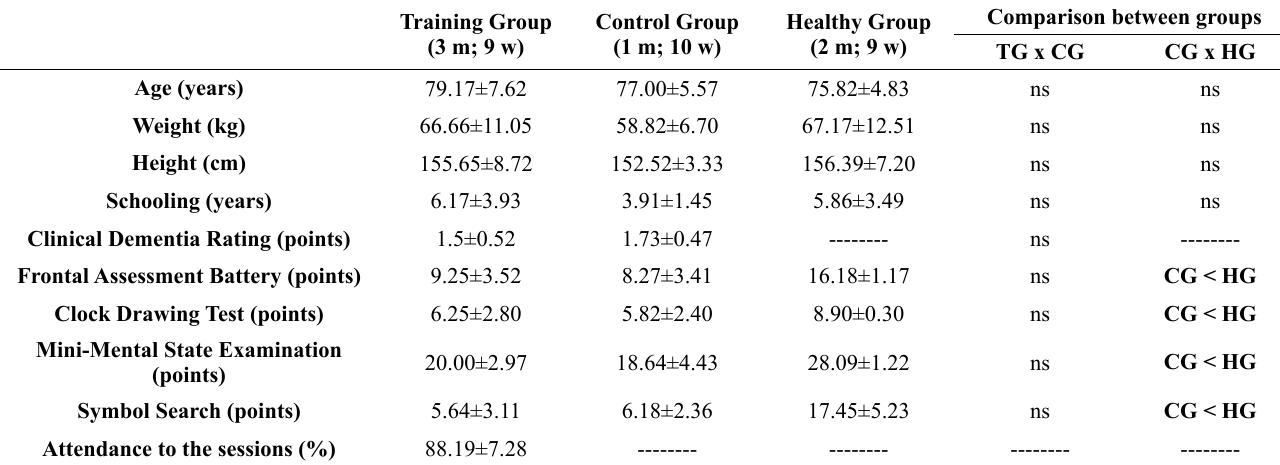
Table 1: Clinical, cognitive and anthropometric characteristics of the participants. The final two columns show the comparison between groups (p<0.05). Comparison between groups Training Group Control Group Healthy Group (3 m; 9 w) (1 m; 10 w) (2 m; 9 w) TG x CG CG x HG Age (years)